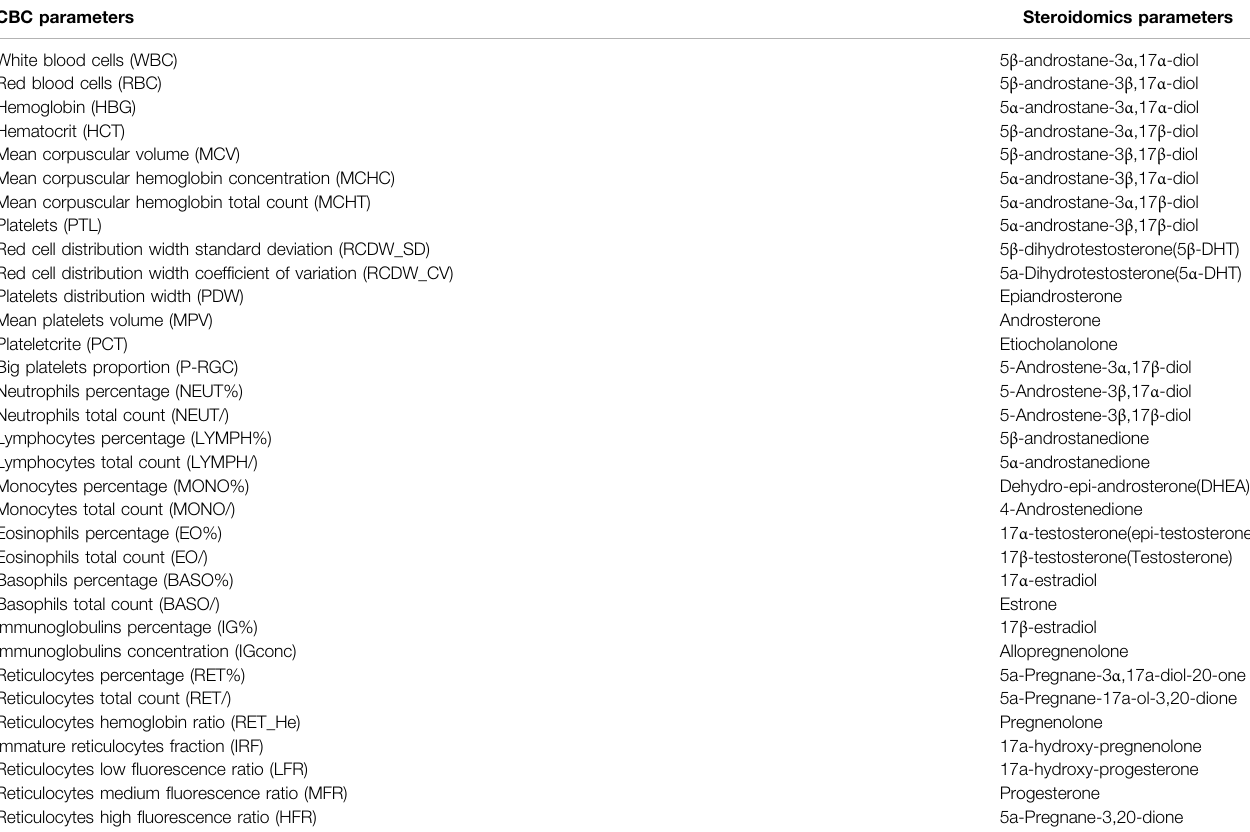
TABLE 1 | The hematologic parameters and the steroids analyzed in this